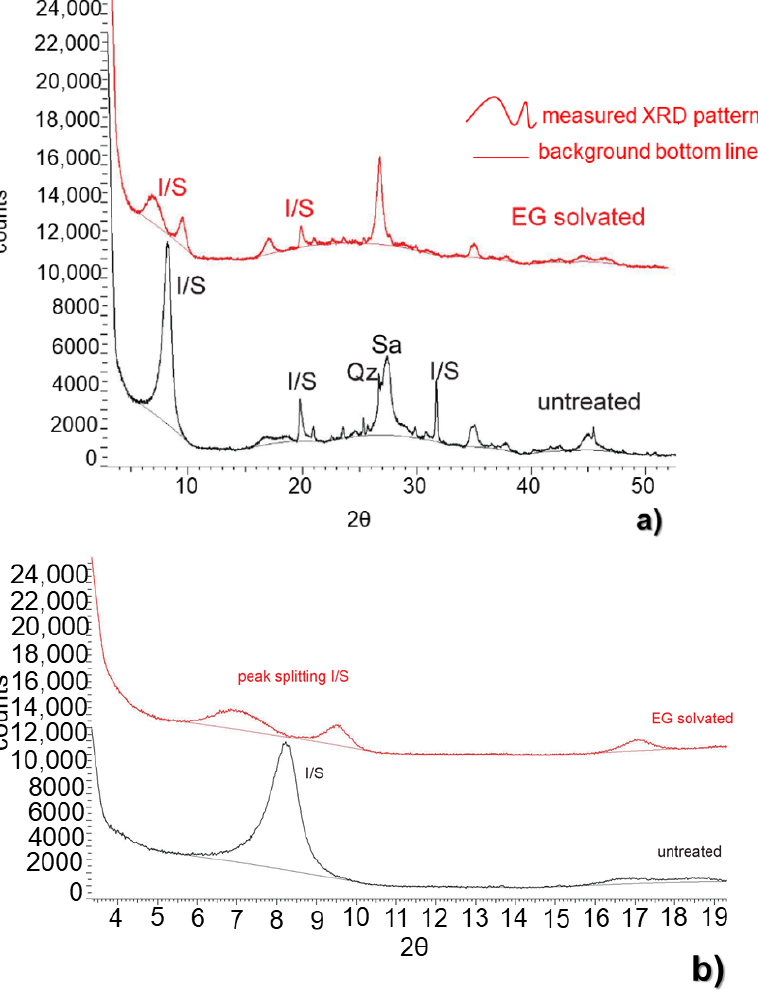
Figure 5. ( a ) X-ray diffraction patterns of the untreated and treated extracted fraction of sample 04MRE123, with the I/S peak signature at 8.4 ◦ 2 θ . Additional peaks were assigned to sanidine and quartz. ( b ) The enrichment in the clay component is visible in the intensity of the peak at 8.4 ◦ 2 θ , compared to the height in the whole rock pattern of the same samples, as shown in Figure 4a,b). The pattern collected after glycol treatment shows the occurrence of two peaks representing a split of the reflex at 8.4 ◦ 2 θ : the peak at 6.7 ◦ 2 θ is assigned to the smectite component of the interlayering